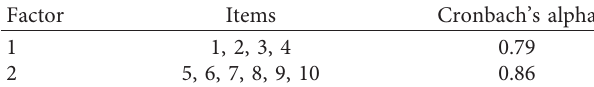
Table 5: Internal consistency for 2 factors of Nepali version. Table 4: Principal component analysis with Varimax rotation: